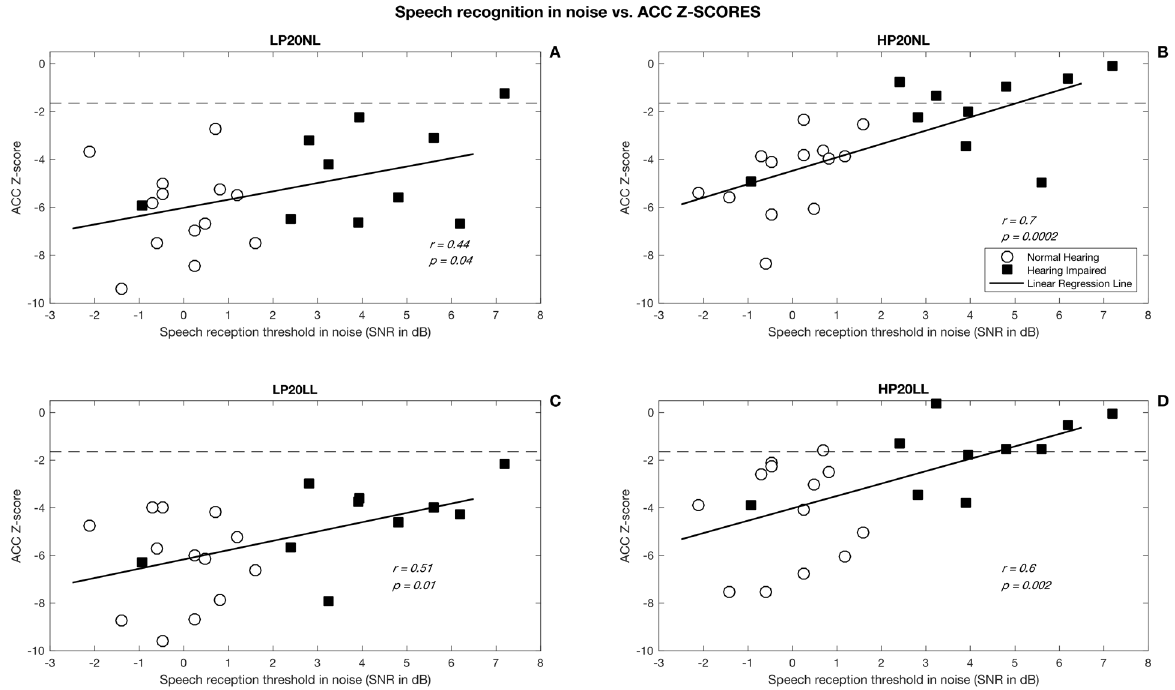
results for the high-pass filtered stimuli presented at normal conversational level (HP20NL), panel ( C ) shows results for the low-pass filtered stimuli presented at low level (LP20LL), and panel ( D ) shows results for the high-pass filtered stimuli presented at low level